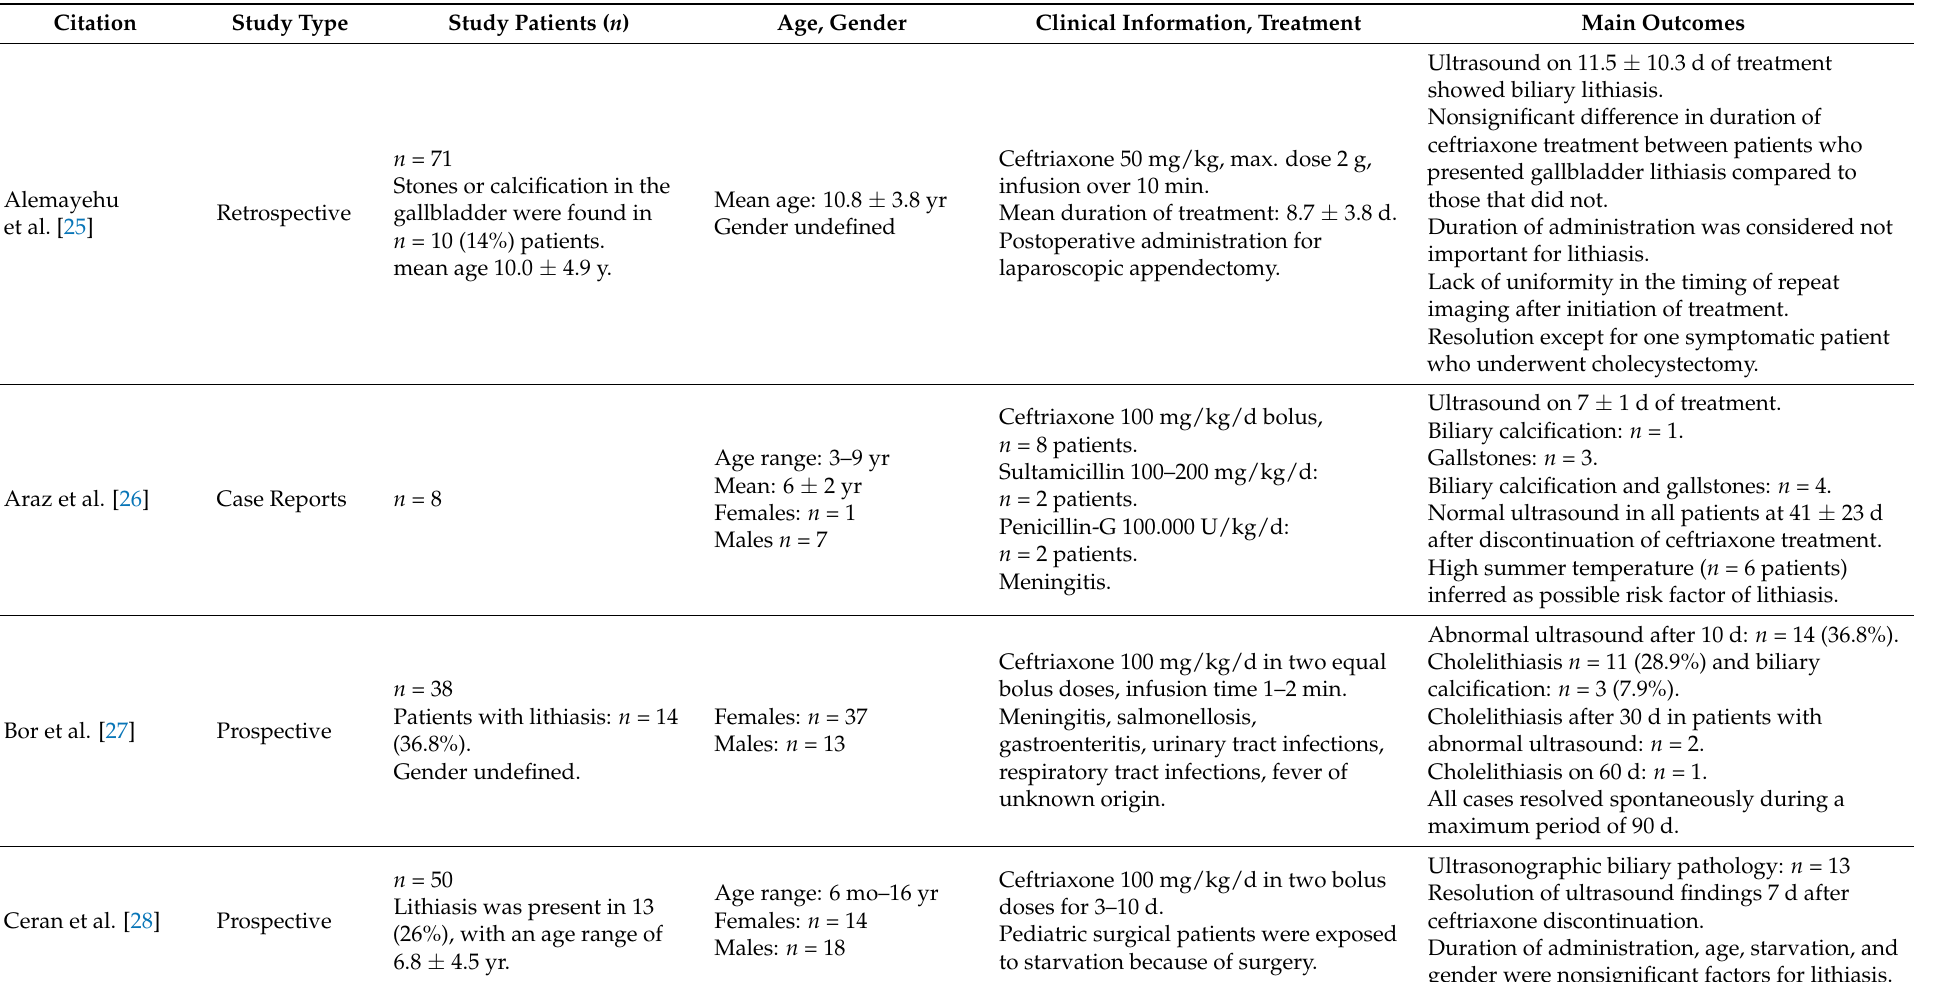
Table 1. Summary of the main findings from the articles included in the study for exclusively biliary ceftriaxone-related